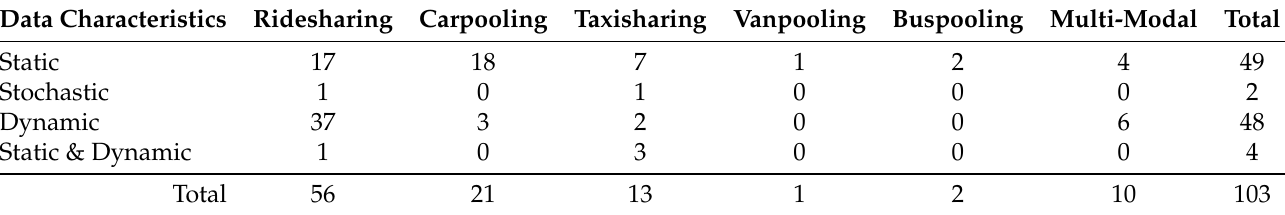
Table 6. Distribution of Papers based on the Data